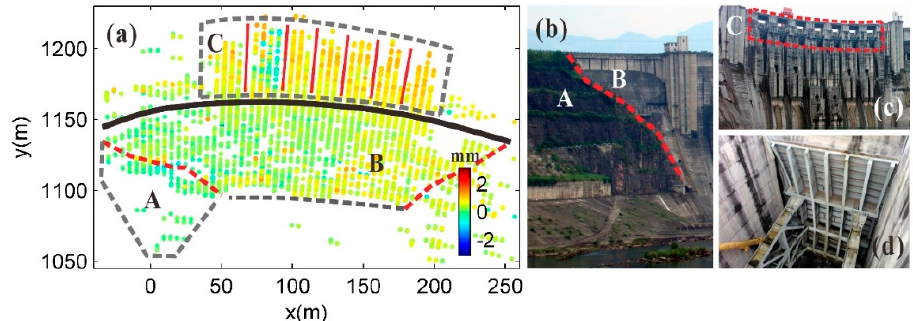
Figure 12. ( a ) Deformation distribution for time period of image subsets S1–S2; identification of deformation areas of the Geheyan dam structure in deformation distribution diagram: ( b ) boundary between right bank slope and dam structure, and ( c ) seven upper outlets of dam; ( d ) gate inside upper outlet release.